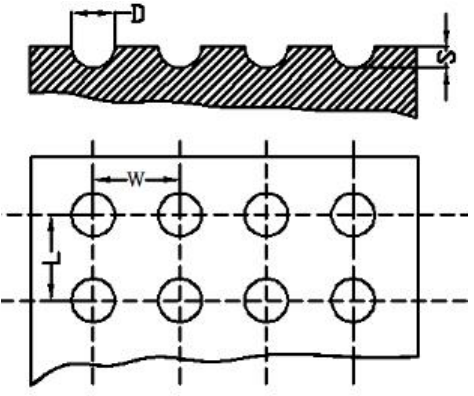
Figure 5. Size of the circular concave structure (mm).